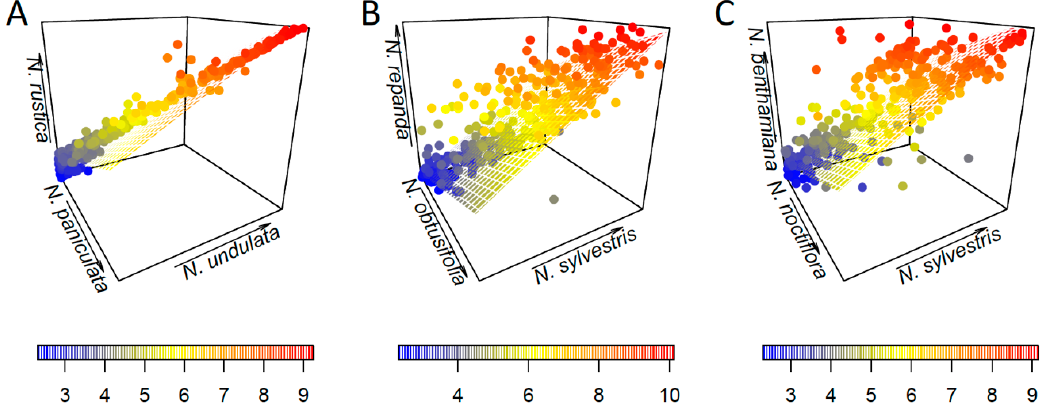
Figure 4. Results of 3D regression analyses. Cluster size is coloured from blue (low) to red (high). ( A ) N. rustica against N. paniculata (maternal) and N. undulata (paternal). ( B ) N. repanda against N. obtusifolia (paternal) and N. sylvestris (maternal). ( C ) N. benthamiana against N. noctiflora (maternal) and N. sylvestris (paternal).